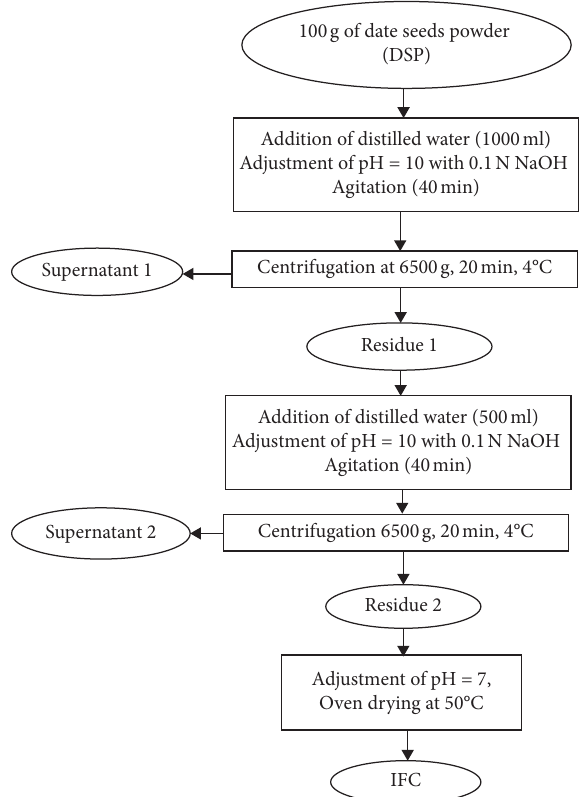
Figure 2: Extraction process of the insoluble fiber concentrate from Deglet Nour date seeds